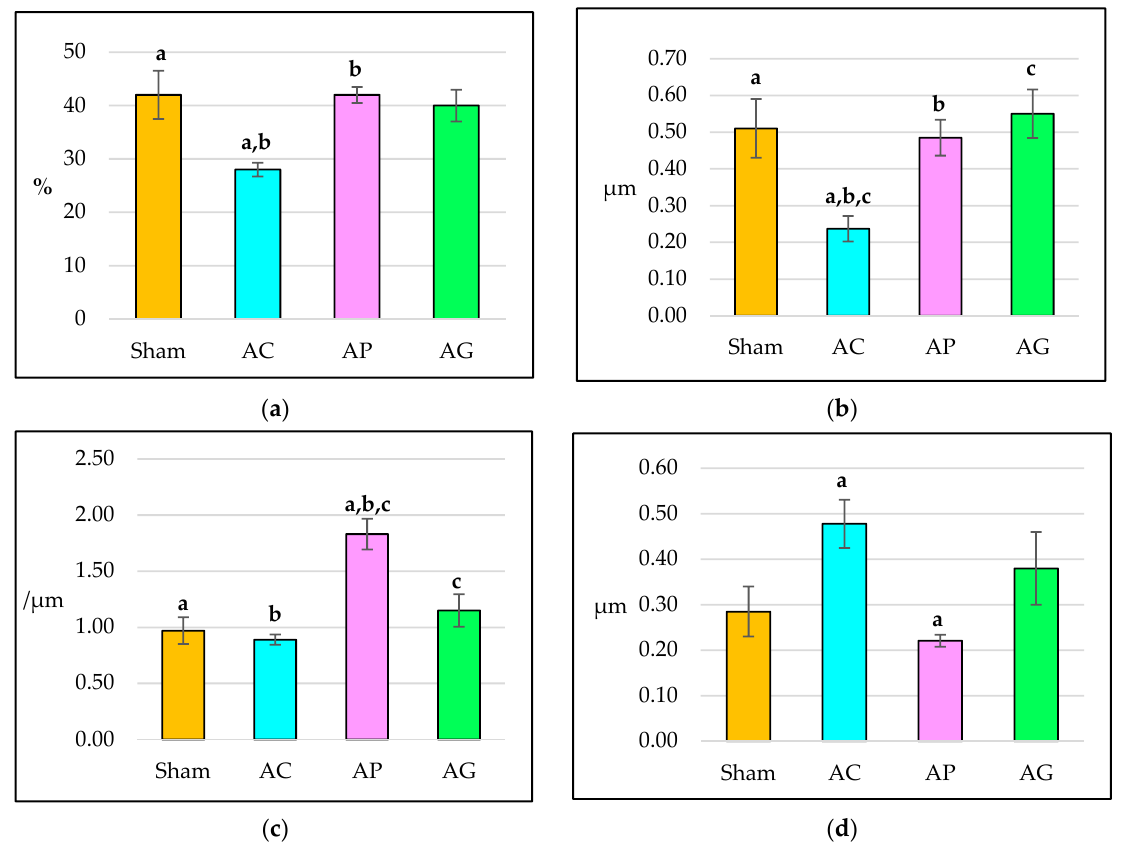
Figure 4. Structural trabecular histomorphometry parameters after 8 weeks of treatment: ( a ) Bone volume (BV / TV); ( b ) Trabecular thickness (Tb.Th); ( c ) Trabecular number (Tb.N); ( d ) Trabecular separation (Tb.Sp). AC: Adrx control given IM DEX 120 µ g / kg / day; AP: Adrx rats given IM DEX 120 µ g / kg / day and aqueous Piper sarmentosum extract 125 mg / kg / day; and AG: Adrx rats given IM DEX 120 µ g / kg / day and GCA 120 mg / kg / day. Data presented as mean ± SEM. Same letters indicate significant di ff erence between groups at p <